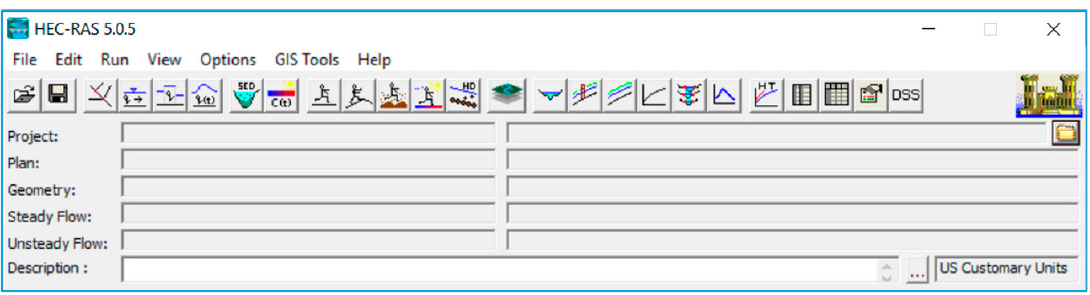
Figure 2. The main menu of HEC-RAS 5.0.3.